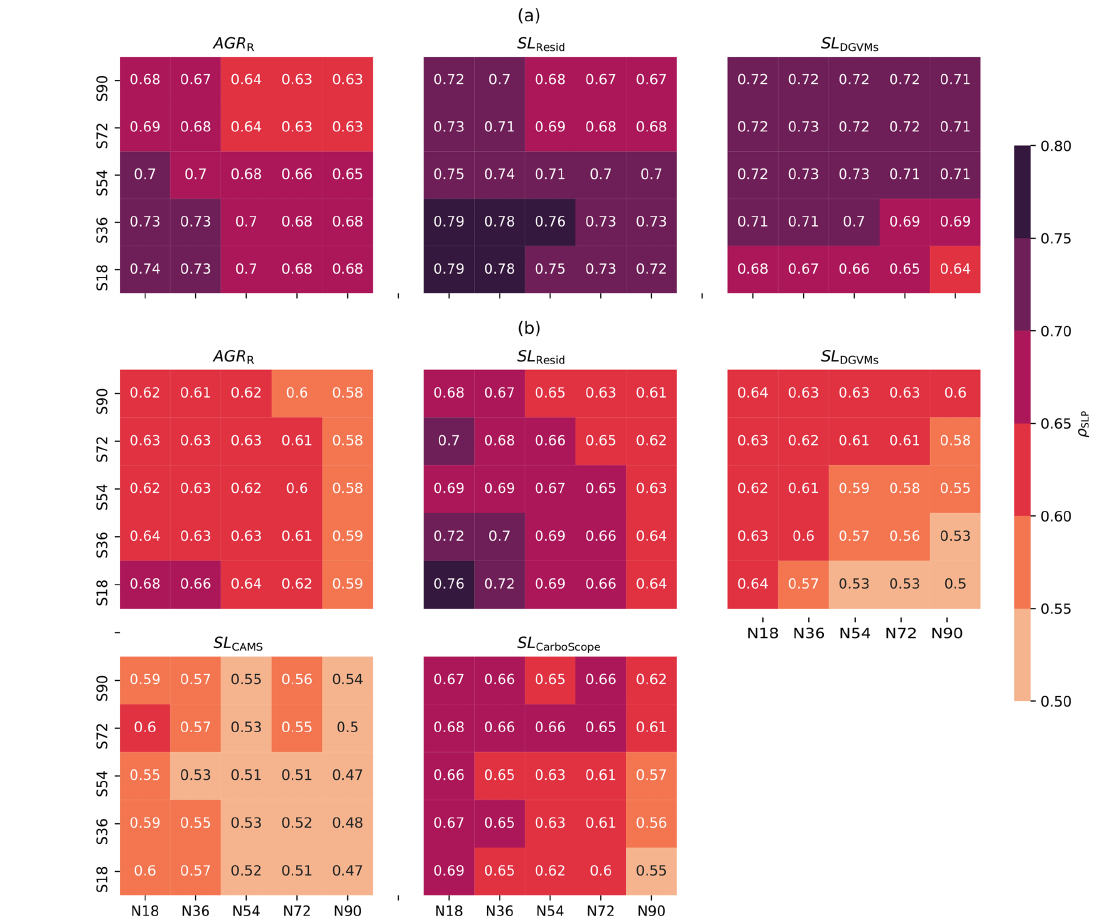
Figure A8. Heat map of ρ SLP with CO 2 time series over various SLP latitude domains in DJF+MAM. Each heat map contains 5 × 5 squares, and each square represents one specific domain of SLP. For example, the square 36 ◦ N–72 ◦ S is the domain of SLP extending from 36 ◦ N to 72 ◦ S. All latitudinal domains include the tropical area (18 ◦ N–18 ◦ S). The top right square thus represents global-scale SLP. The time series is from (a) 1959–2017 for AGR R , SL Resid , and SL DGVMs . (b) 1980–2017 included two more inversions: SL CAMS and SL CarboScope .